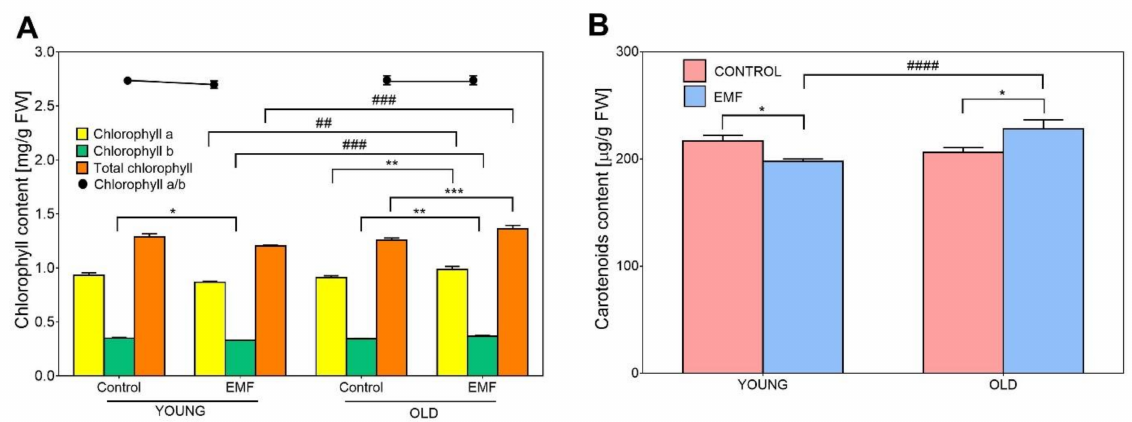
Figure 5. Photosynthetic pigments content of chlorophylls ( A ) and carotenoids ( B ) in leaves of two-week-old plants of field beans growing in pots from young and old seeds treated with EMF, and their controls. Data are the means ± SE ( n = 3). The symbol (*) indicates significant differences between EMF-treated and control groups (* p < 0.05, ** p < 0.01 and *** p < 0.001); “#” indicates significant differences between EMF-treated groups ( ## p < 0.01, ### p < 0.001, #### p <